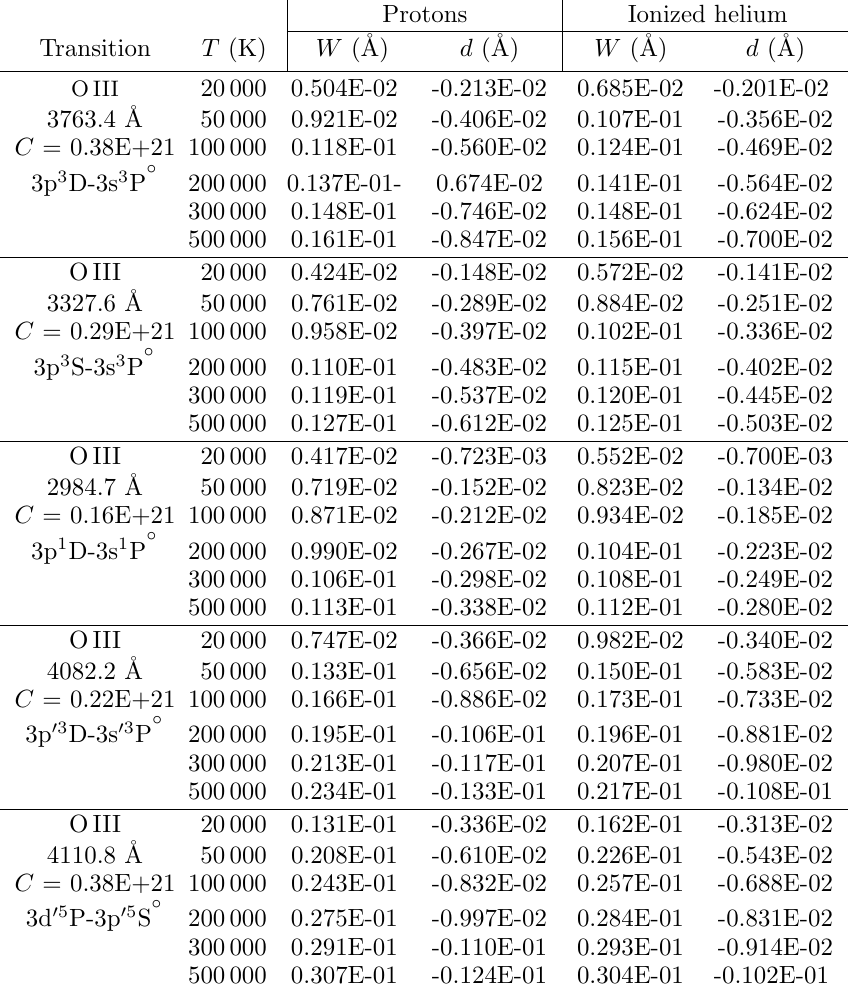
Table 4. Stark broadening parameters for O III multiplets. for a perturber density of 10 17 cm − 3 . Designations are the same as in Table